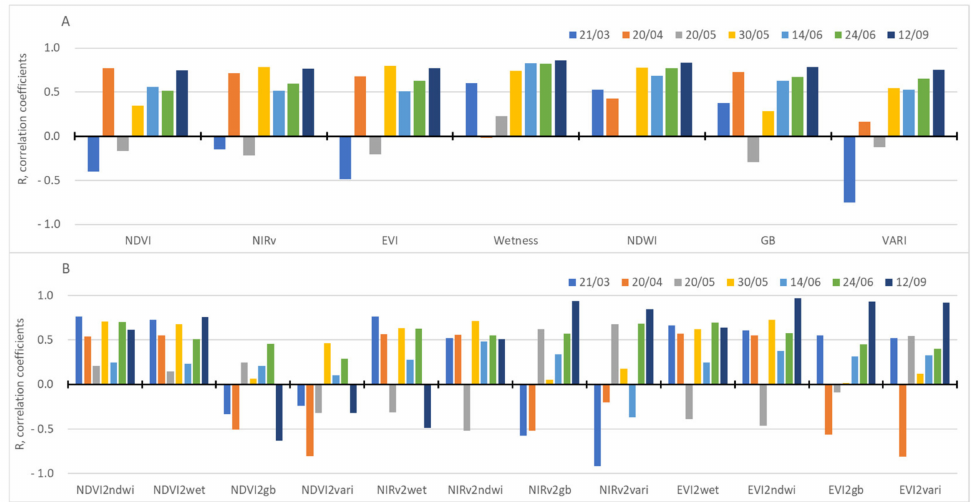
Figure 3. The correlation between the LWP and the spectral indices ( A ) and the OSI combinations ( B ).